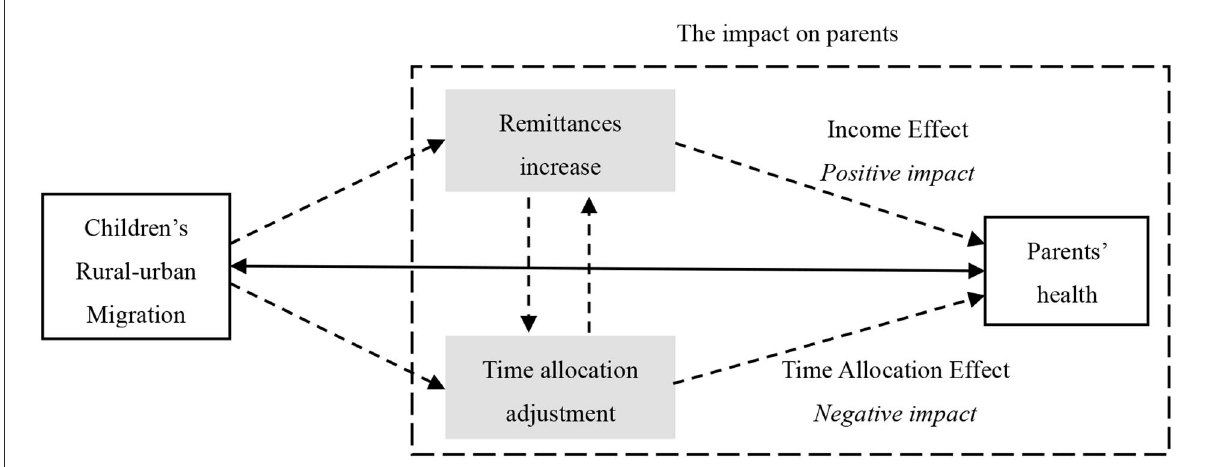
FIGURE1 Theoretical mechanism of the impact of children’s migration on their parents’